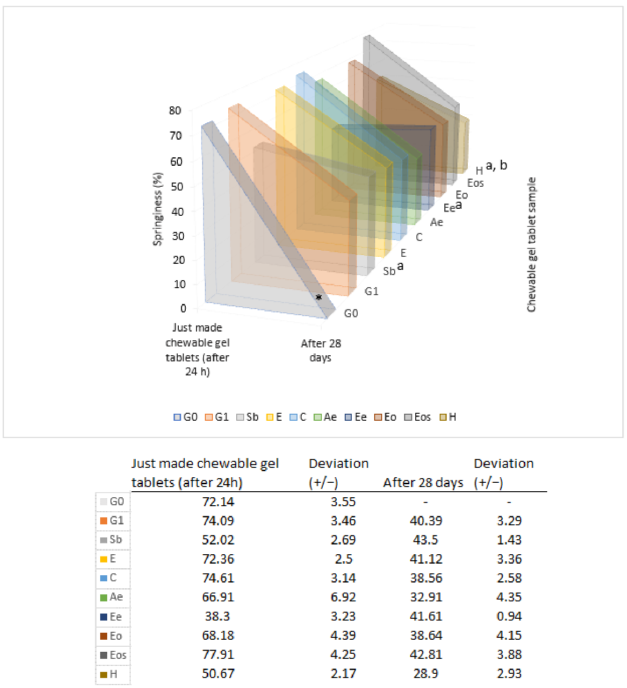
Figure 8. Springiness’ change in chewable gel tablets after 28 days kept at room temperature in an open plastic bag. * Device did not measure value after 28 days, a statistically significant change after 24 h vs. G1; b—statistically significant change after 28 days vs. G1, p < 0.05, n =